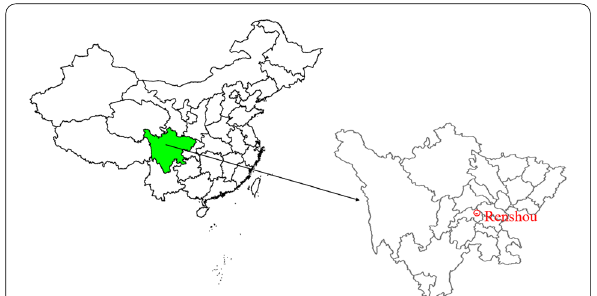
Fig. 1 Location of the study